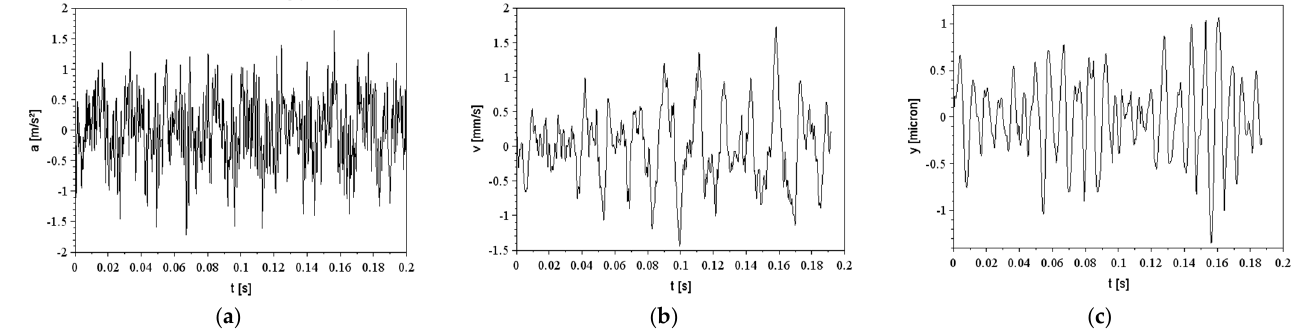
Figure 11. Excitation signals in stable TSC = 21.43 mm − 1 conditions with an ID boring bar: ( a ) accel- eration; ( b ) velocity; ( c ) displacement amplitudes.